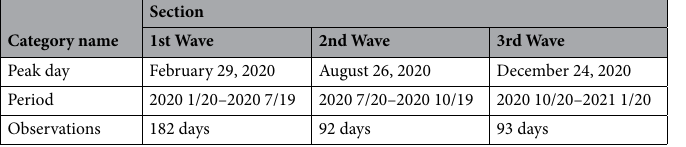
Table 2. Division of periods of COVID-19 spread, for the empirical verification of weakened